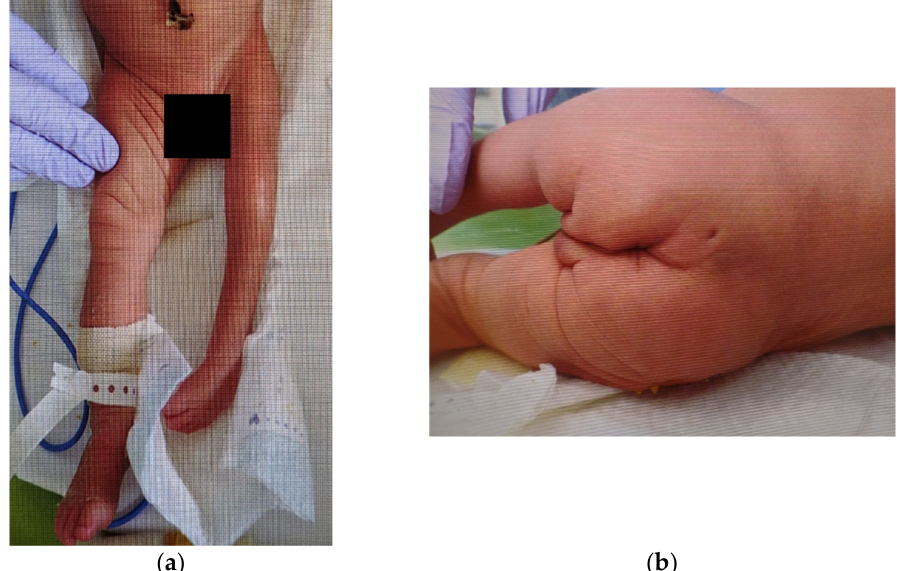
Figure 1. External findings of the lower extremities and buttocks: ( a ) Hypoplasia is observed in the left lower extremity. Spontaneous movements and tendon reflexes are absent. There are no abnormal findings in the right lower extremity; ( b ) A small dimple is observed in the skin of the lumbosacral region and a curvature of the gluteal cleft.